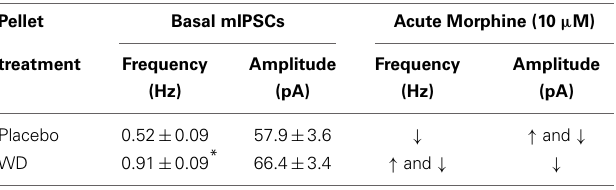
Table 1 | Summary of acute morphine-induced changes in mIPSCs in CeA neurons of placebo and morphine (WD) pellet–treated rats.